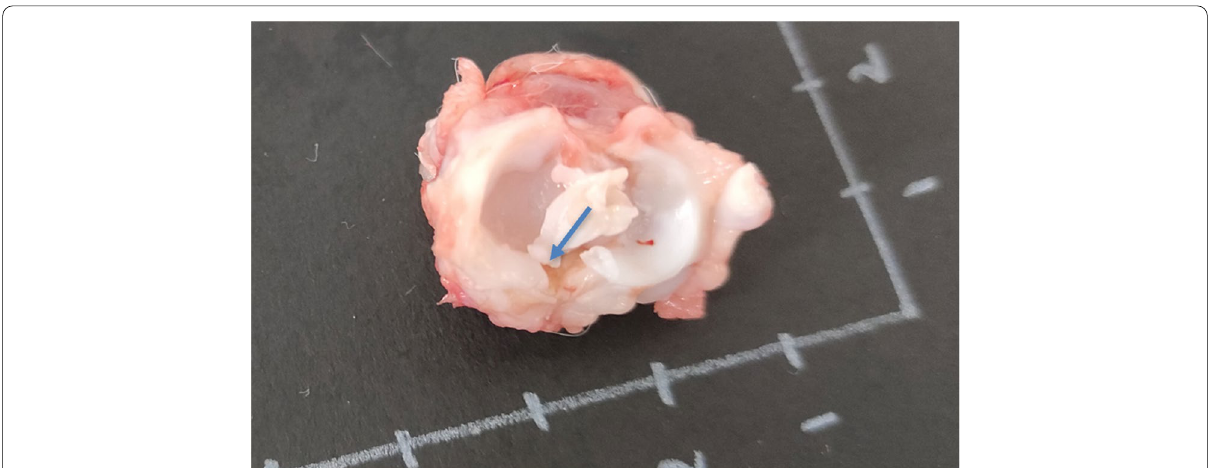
Fig. 2 Representative image of meniscal root remnant after 16‑weeks of partial